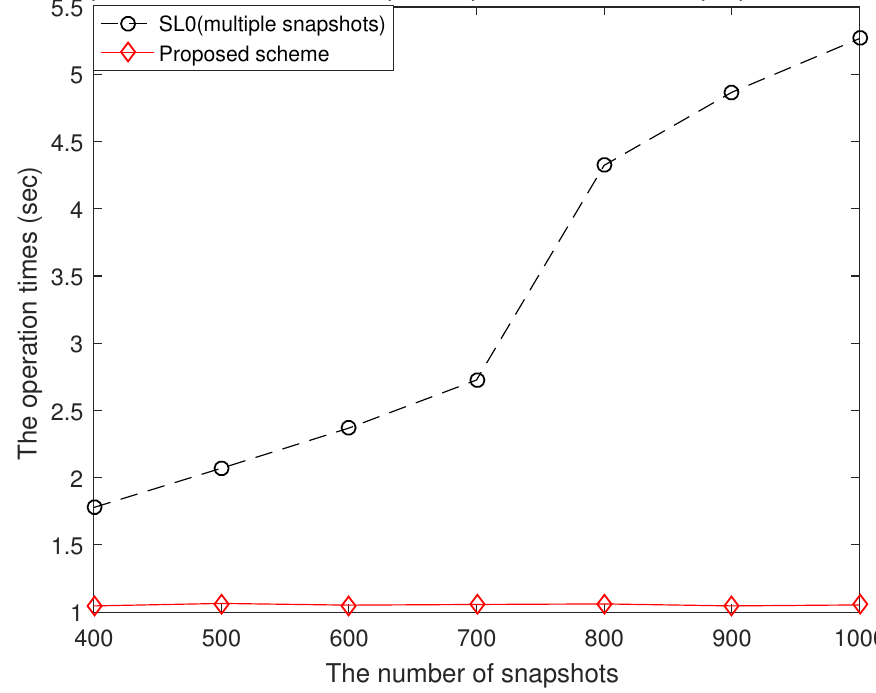
Figure 7. The operation times of the multiple snapshots SL0 and the proposed